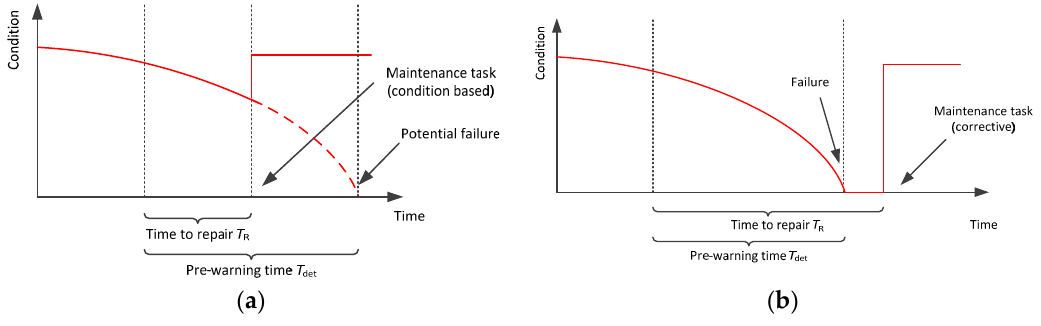
Figure 3. Possible outcomes of scenarios in which a potential failure is detected: ( a ) outcome for T R < T det , resulting in CBM; ( b ) outcome for T R > T det , resulting in CM.